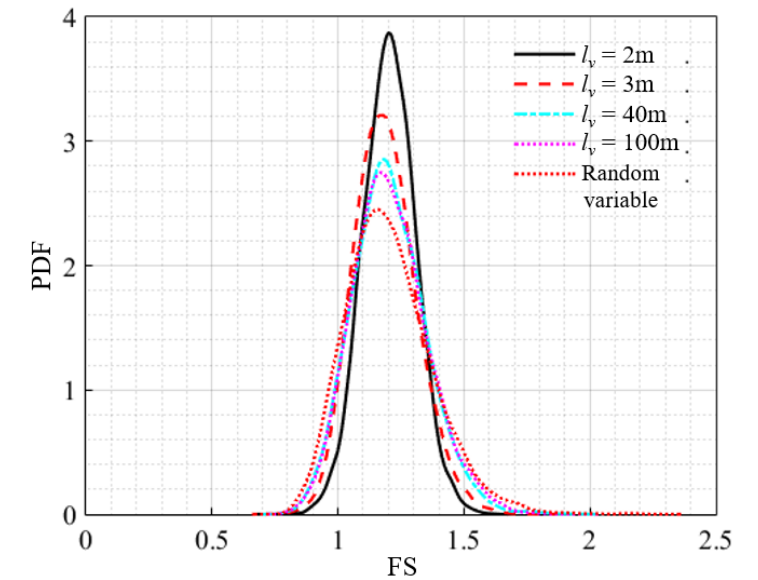
Figure 15. PDFs for different autocorrelation lengths.